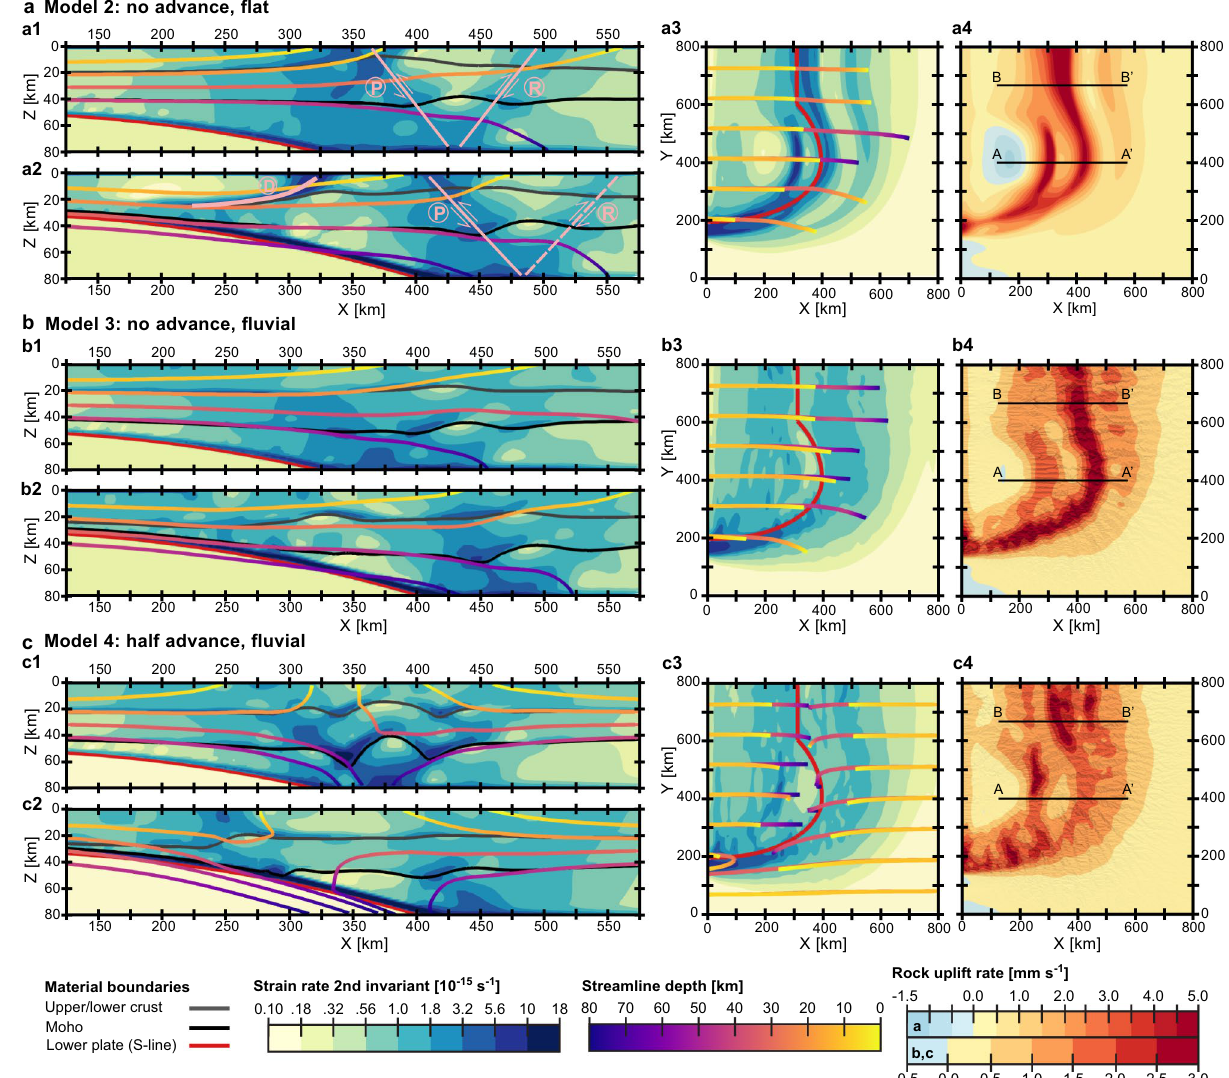
Figure 4. Strain rate (shown in vertical cross-sections and plan view) and rock uplift rates (top view) after 6 Myr modelling time for ( a ) model 2 (total erosion; no upper plate advance); ( b ) model 3 (fluvial erosion; no upper plate advance); and ( c ) model 4 (fluvial erosion; half upper plate advance). Figure conventions as in Fig. 3. Note that in the models without the upper plate advance component (panels “a” and “b”), the relatively shallow (i.e., originated at 10–20 km depth) particle streamlines show a gradual increase in exhumation of upper and lower crustal material from the left (subduction) side of the model towards its center. In the experiment characterized by fluvial erosion and half upper plate advance (panel “c”), the zones of strong rock uplift at the surface coincide with the three main deformation structures of the model: (1) the orogenic wedge above the cylindrical slab; (2) the indenter-centered decollement; and (3) the transform fault bounding the lateral margin of the subducting plate (see Fig.